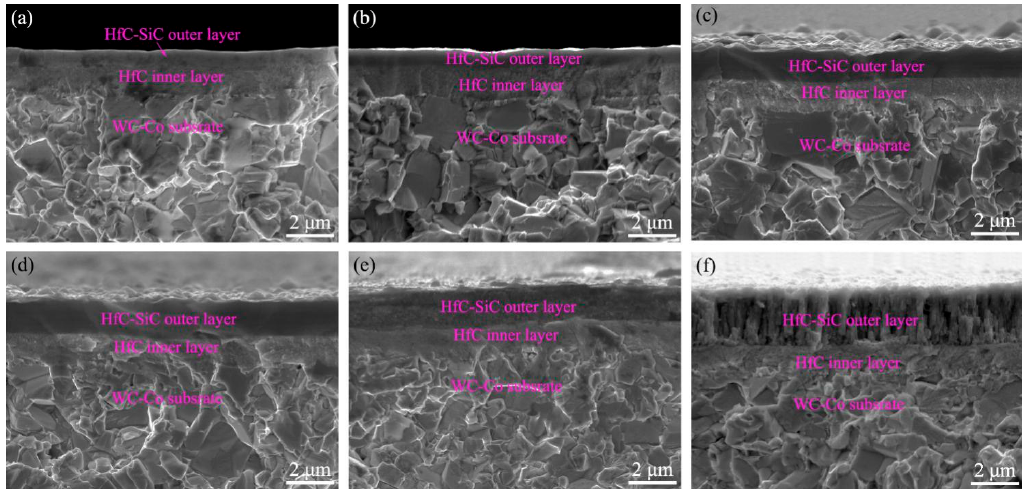
Figure 5. Cross-sectional SEM images of the HfC-SiC mixed bi-interlayers prepared with different TMS